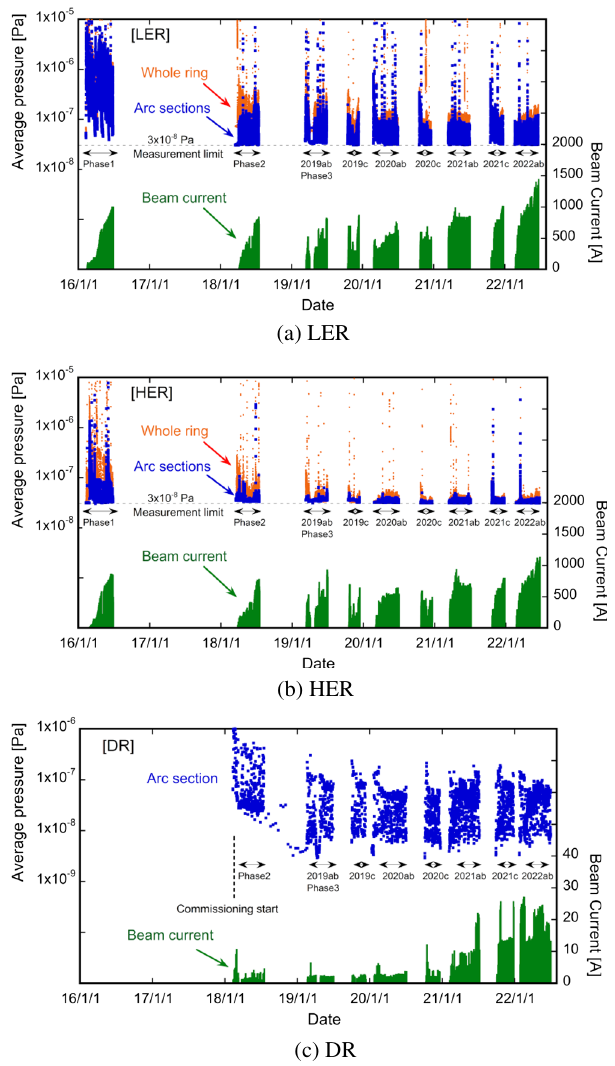
FIG. 4. Trends of pressures and beam currents since Phase-1 commissioning in 2016 for (a) LER, (b) HER, and (c) DR.